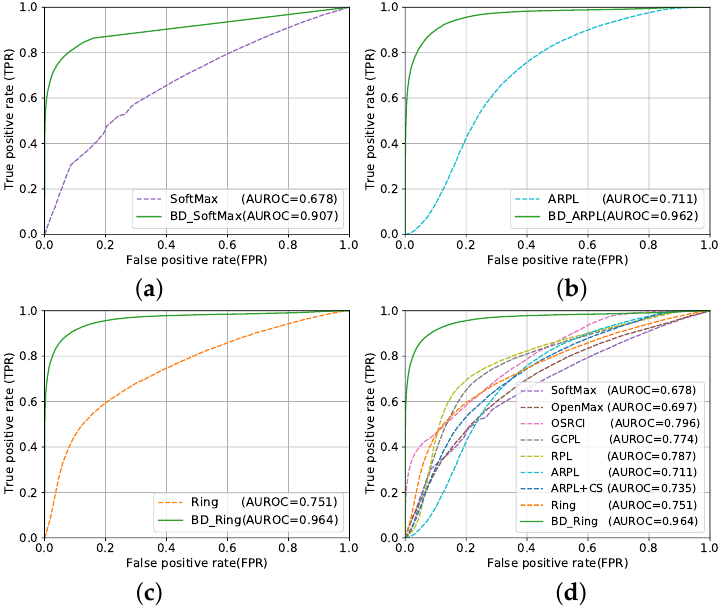
Figure 6. This figure shows the ROC curve of some experimental results in Table 2. Among them, ( a – c ) intuitively demonstrate the performance improvement effect of the proposed method combined with the specific method, and ( d ) shows a comparison of the proposed method BD_Ring with the remaining methods. Moreover, parameter k in this figure is set to 5. ( a ) SoftMax; ( b ) ARPL; ( c ) Ring; ( d ) All